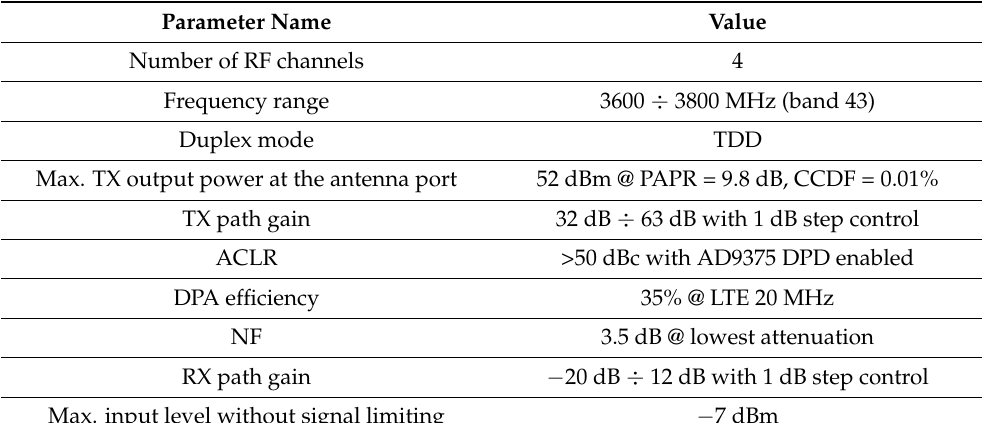
Figure 6. LTE 20 MHz signal spectrum at the single channel output of the B43 RF front-end with and without DPD algorithm enabled at power level close to the maximum available. DPD algorithm: the one implemented in AD9375. Table 2. Measured performances of the single channel of the B43 RF front-end.